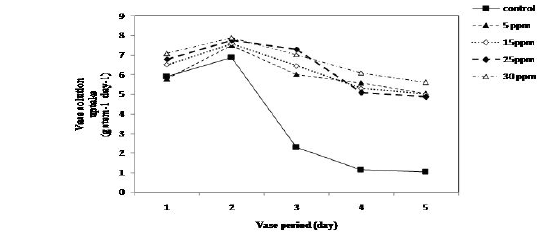
Fig. 4. Number of bacteria in vase solution of cut Lilium